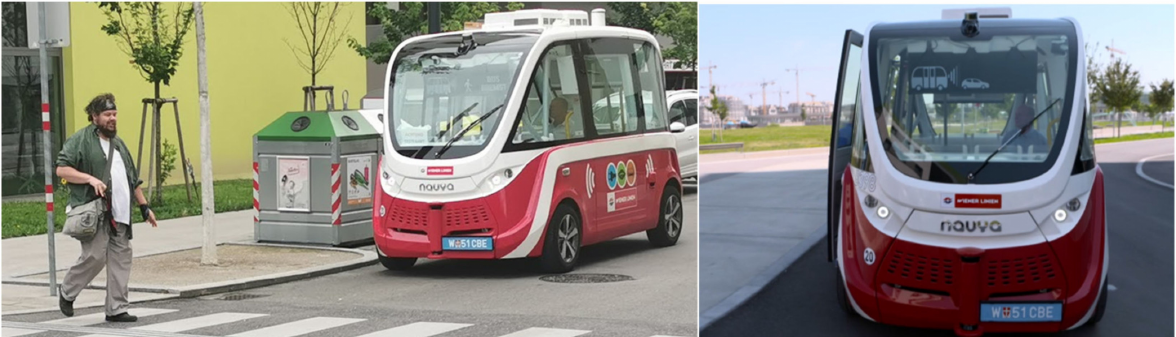
Figure 1. Automated shuttle (AS) that was used in this